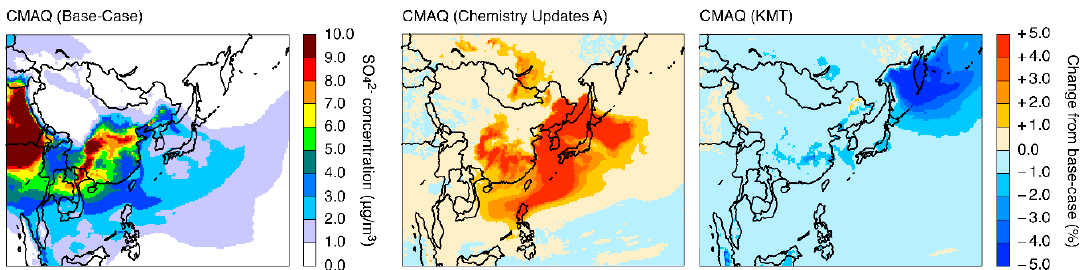
Figure 1. Spatial distribution of ( left ) SO 42– concentrations simulated by the CMAQ base-case simulation for domain 1 and ( right ) changes in SO 42– concentrations for chemistry updates A and KMT averaged over the period 15–25 December 2016.